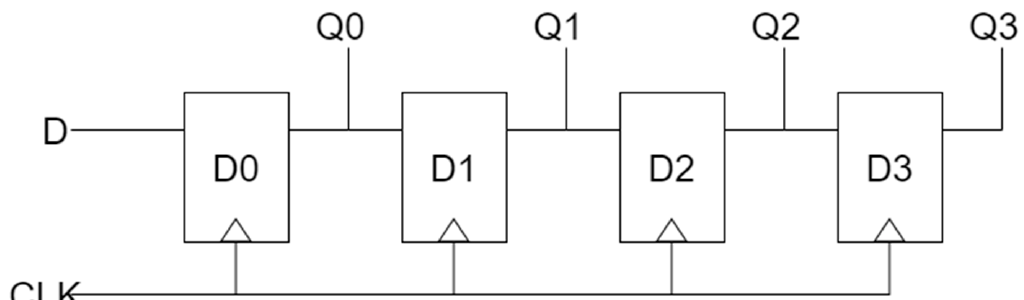
Figure 6. A logic diagram of 4-bit shift register.